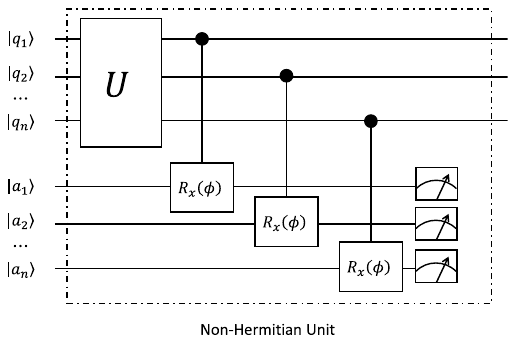
Figure 4. The circuit for simulating a N -qubits non-Hermitian system. The repeating strategy is the same as that has been described in the main text. q i denotes the N system qubits, a i denotes the N ancilla qubits and U is the unitary evolution gates applied on the system qubits. The initial states of the system qubits can be arbitrary, 0 but the initial states of the ancilla qubits are all | �